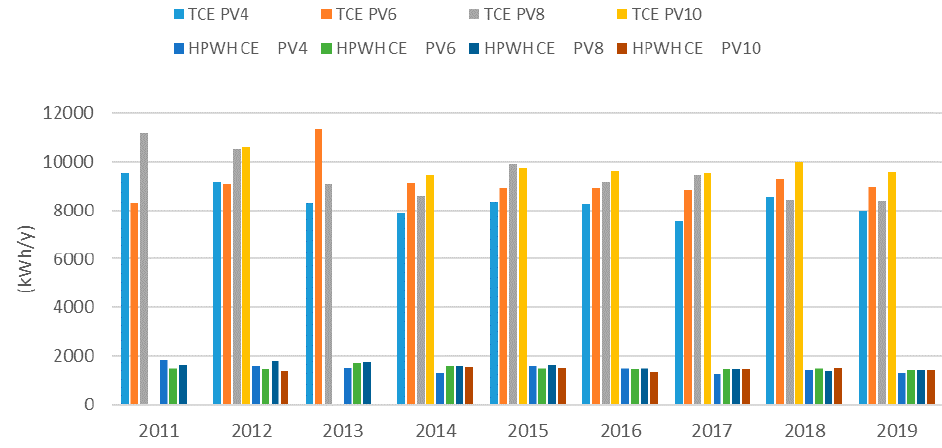
Figure 16. Annual power consumption and HPWH of construction year.